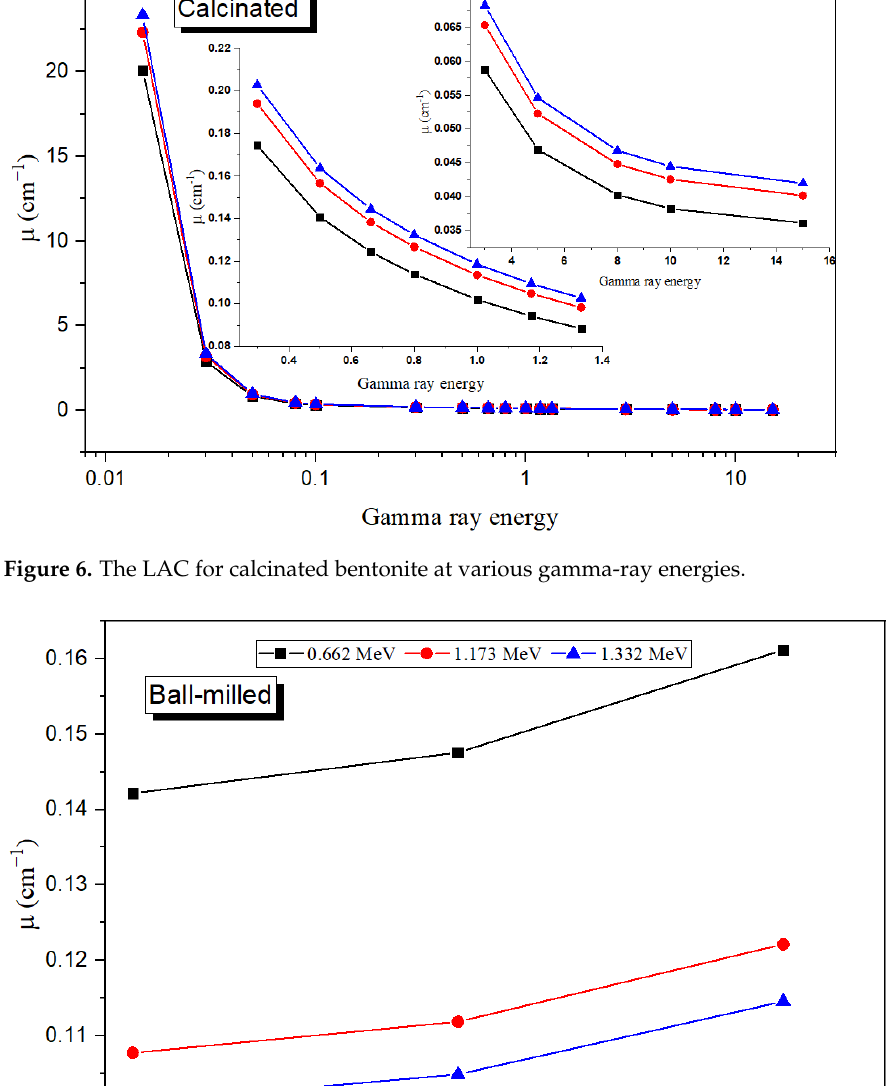
Figure 5. The linear attenuation coefficient for ball-milled bentonite at various gamma-ray ener- gies.